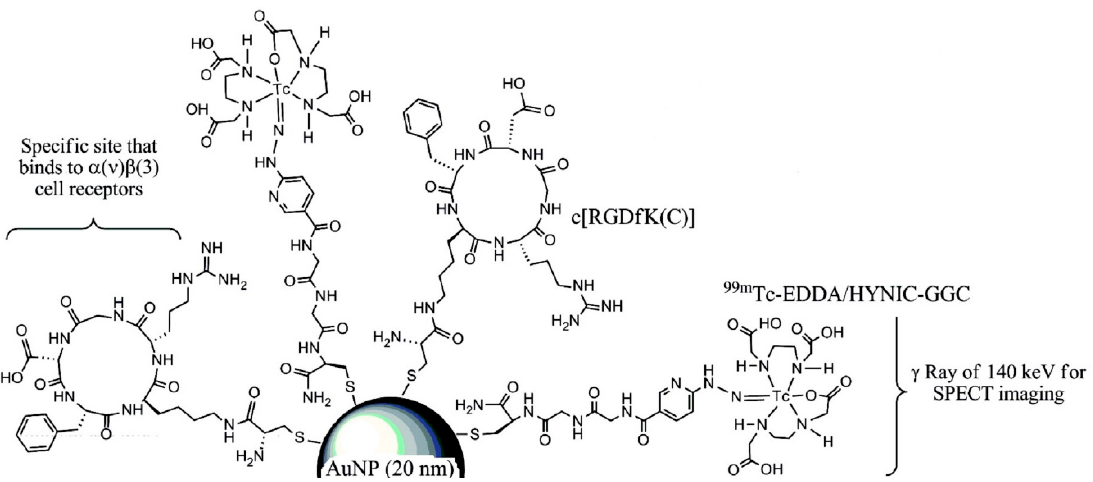
Figure 10. Illustrative scheme of [ 99m Tc]Tc-EDDA/HYNIC-GGC conjugated to RGD derivative and gold NP [119].